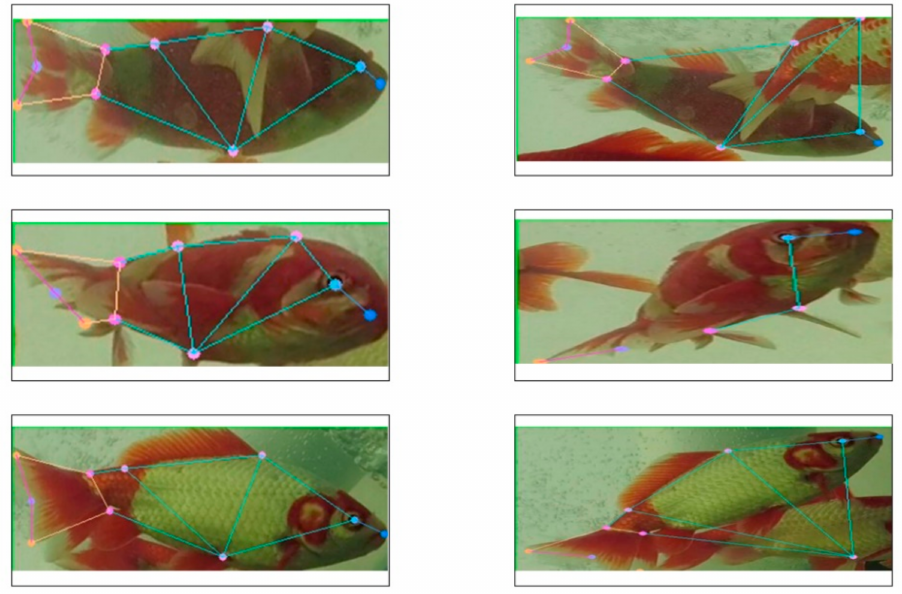
Figure 13. Comparison of rotating object detection results. The figure on the left is the result of the rotating object detection group, and the figure on the right is the result of the ordinary object detection group.